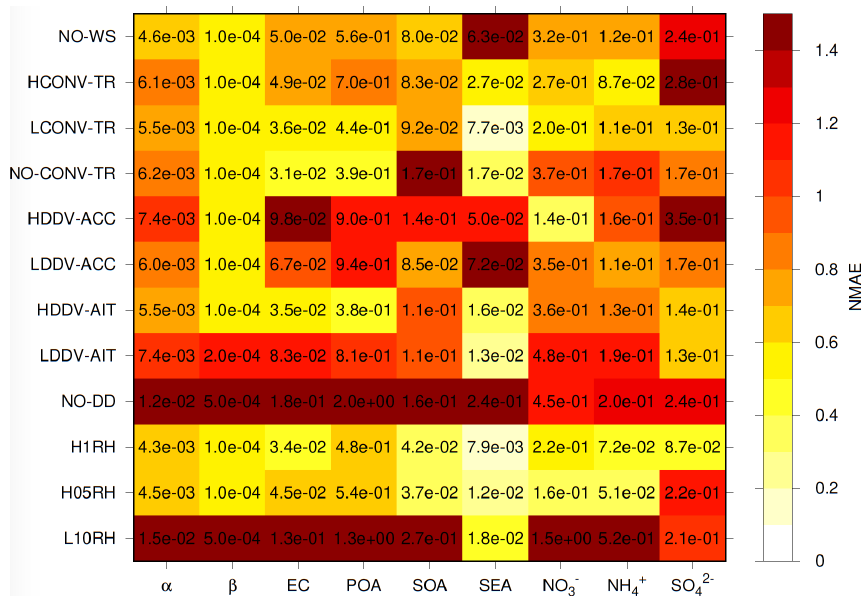
Figure 8. As Fig. 4 but over Moscow